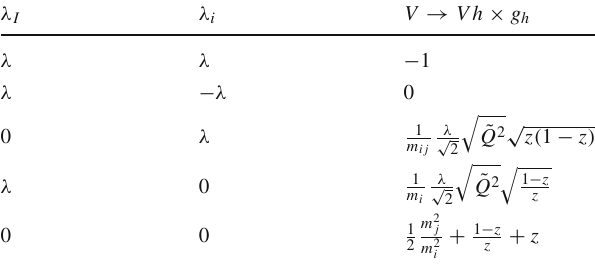
Table 6 Branching amplitudes for Higgs emission off a vector boson